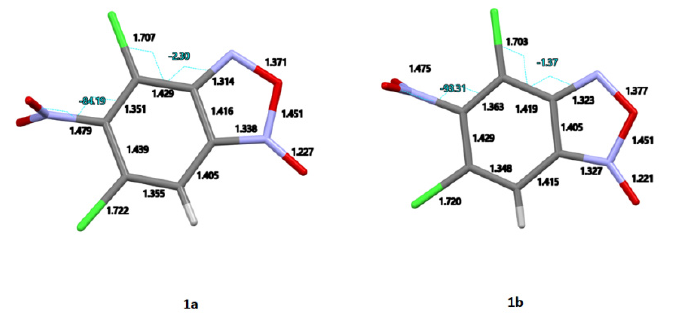
Figure 4. Geometry of 1a ( left ) and 1b ( right ).